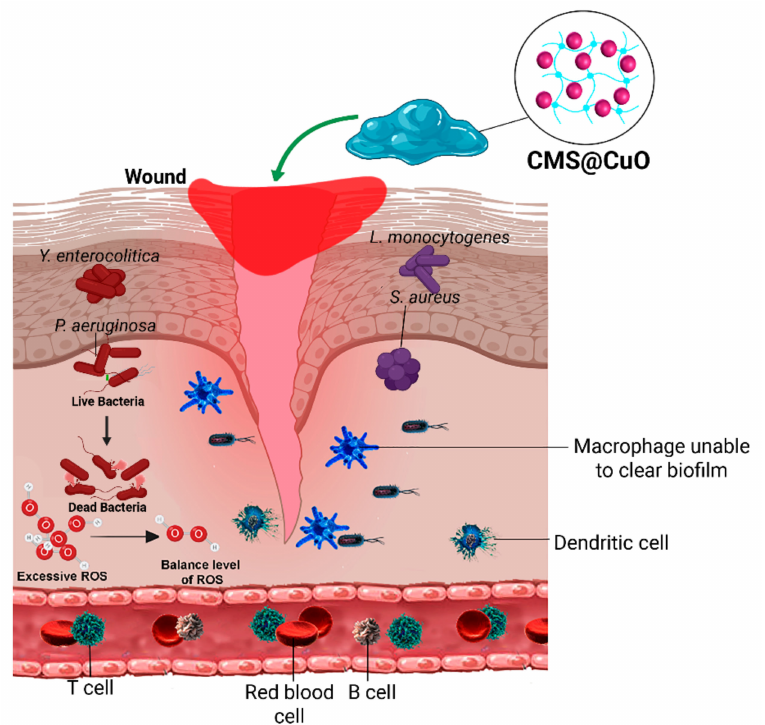
Figure 8. Schematic of the application of a nanocomposite hydrogel with antibacterial and antioxidant properties to promote wound